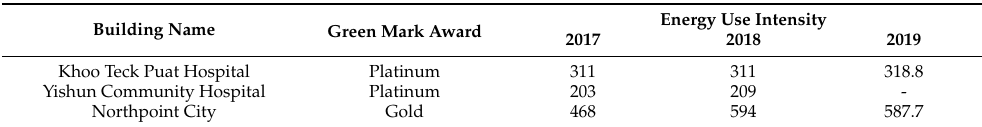
Table 4. Comparison of Green Mark buildings’ energy use intensity located in Khatib in the years of 2017, 2018, and 2019.